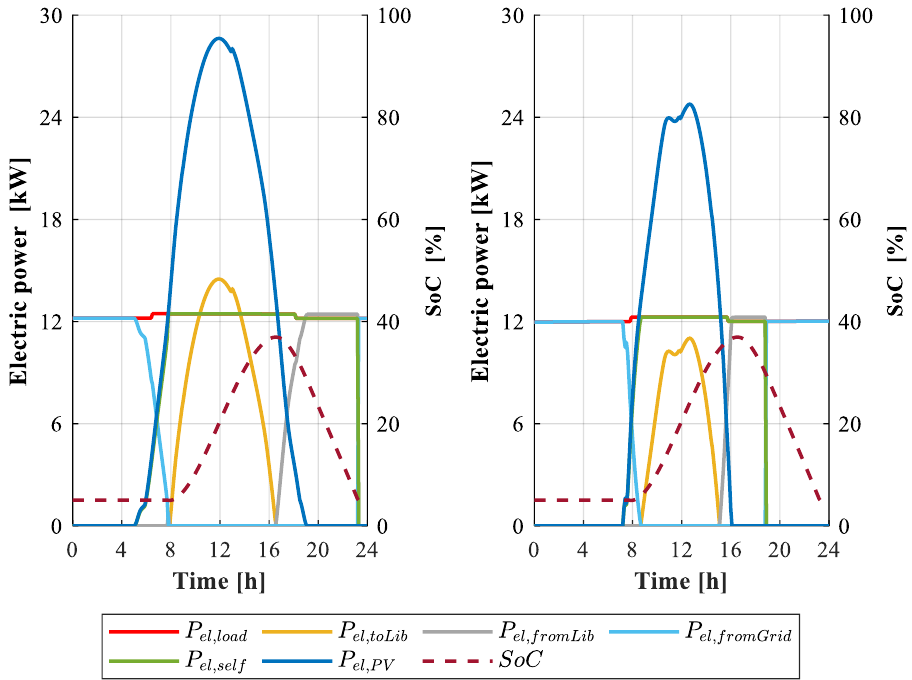
Figure 4. Dynamic results for electric powers in typical summer ( left ) and winter ( right ) day.